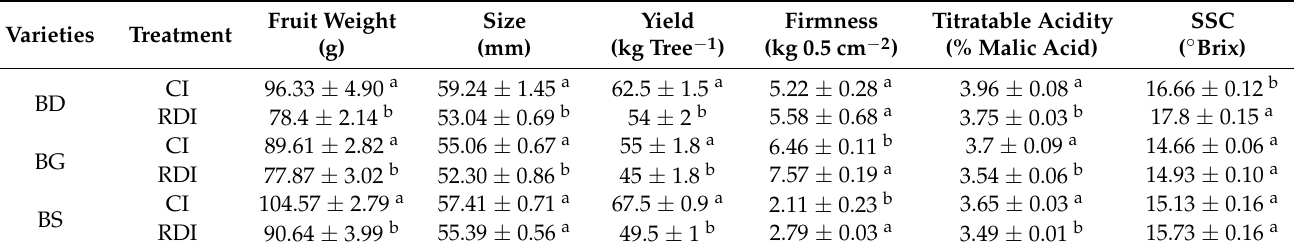
Table 3. Effect of regulated-deficit irrigation (RDI) on fruit yield and pomological parameter of the fruits of three plum cultivars: BD: Black Diamant, BG: Black Gold, and BS: Black Star in the centre of